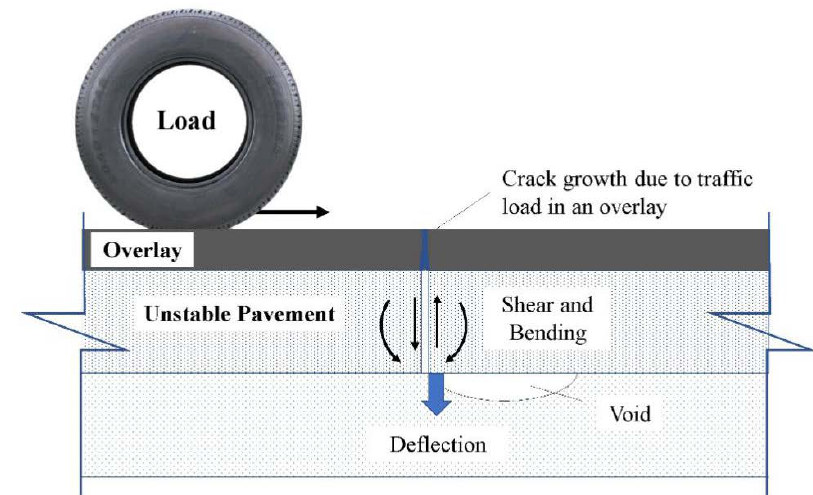
Figure 2. Loading and stresses in asphalt pavement.